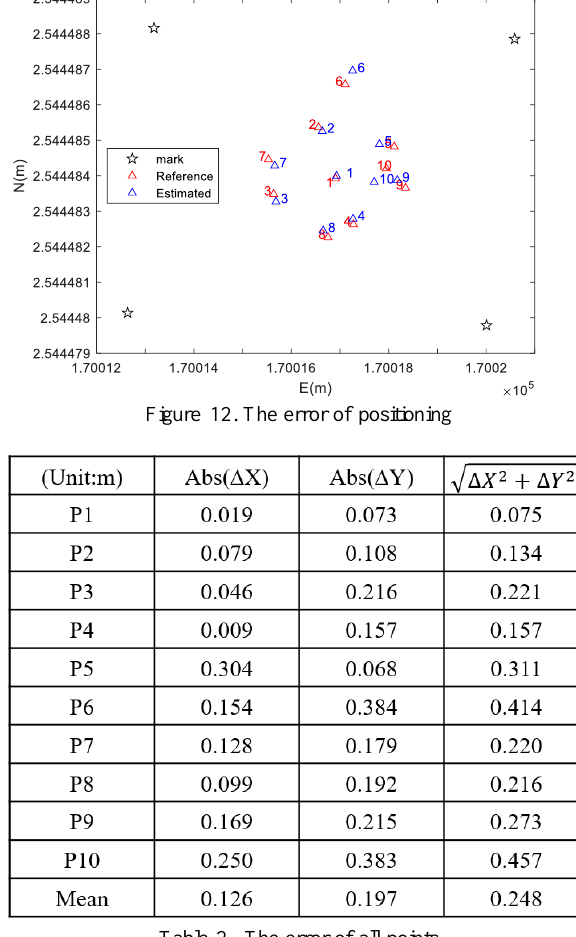
Table 2. The error of all points The red and blue triangles are the positions measured by the total station and calculated by the trilateration algorithm